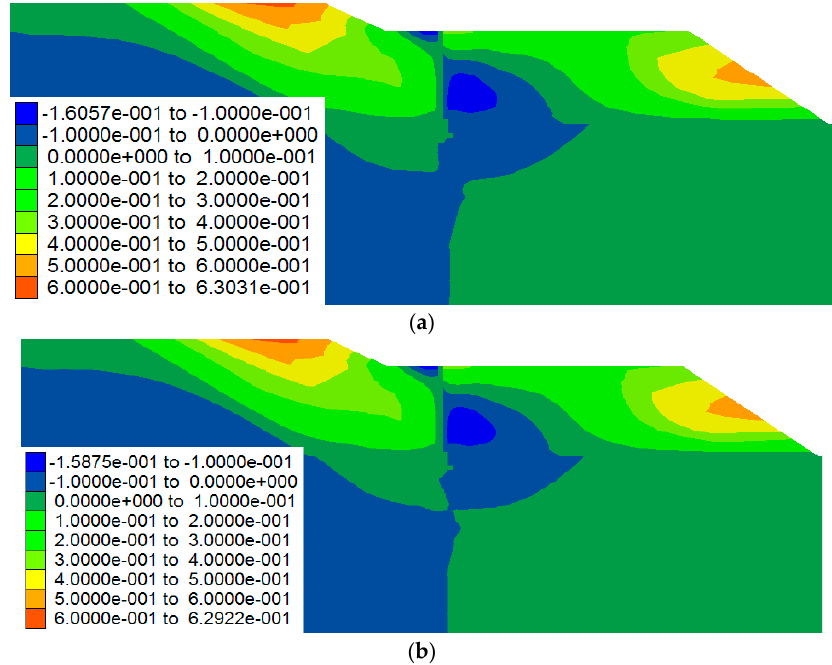
Figure 7. Horizontal displacement nephogram of monitoring surface. ( a ) 1. ( b ) 2.